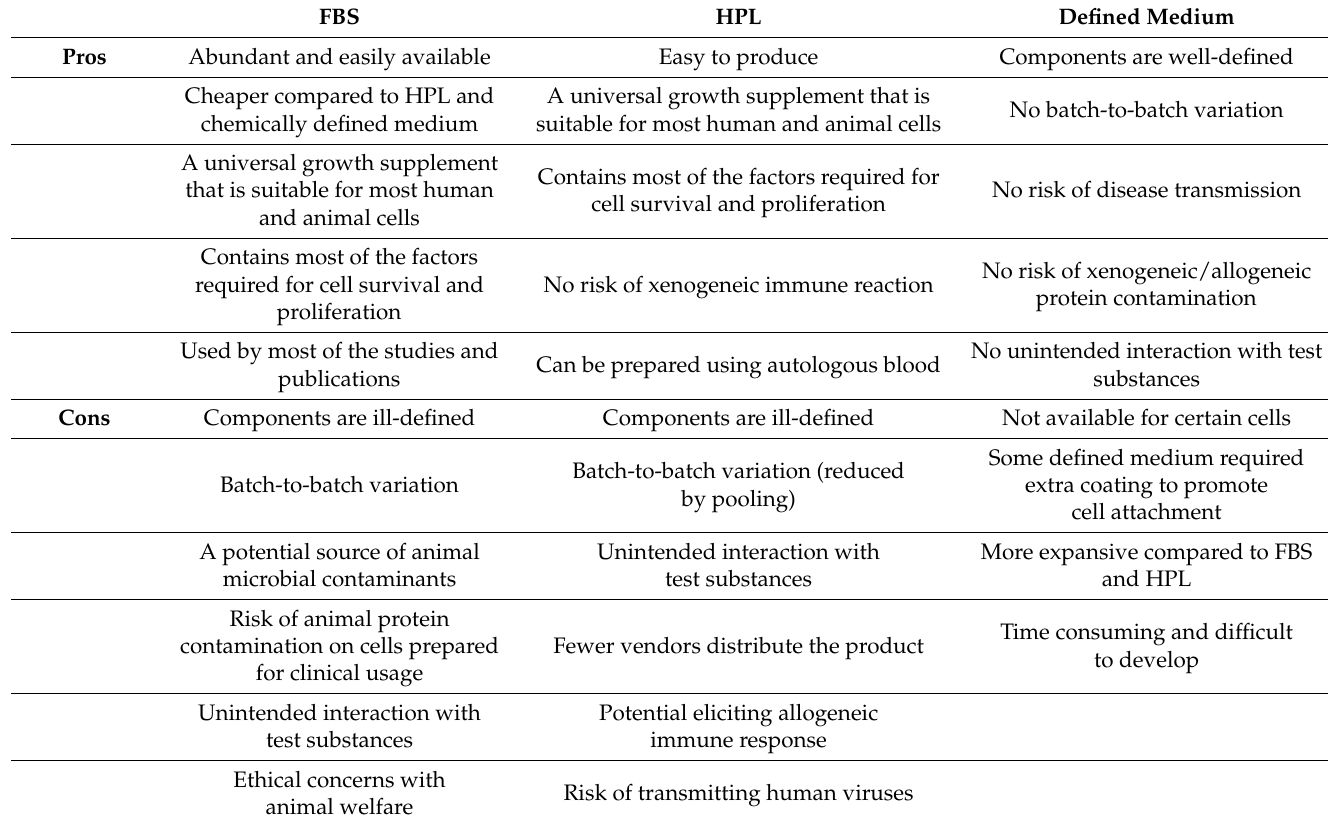
Table 1. Pros and cons of FBS, HPL and defined medium in cell culture. FBS